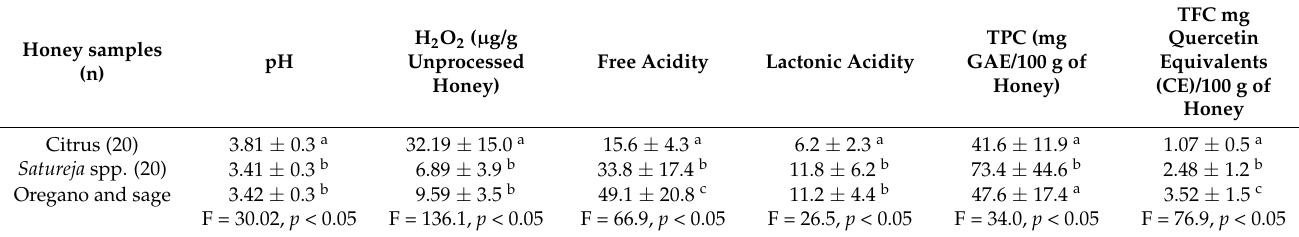
Table 8. Physicochemical characteristics of the honey types used in the